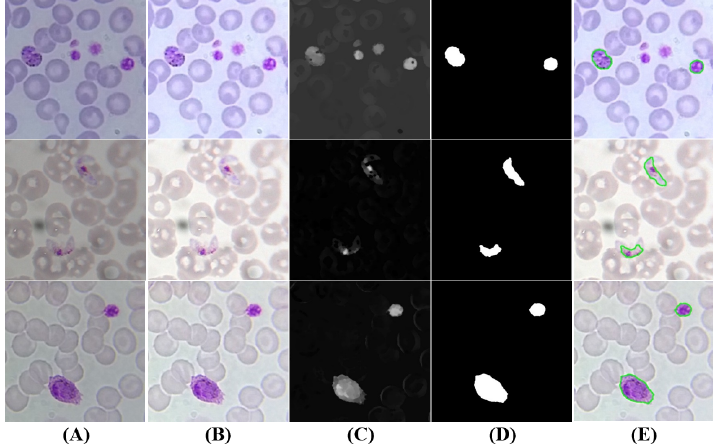
Figure 10. Gametocytes candidates: ( A ) original image (cropped ROI); ( B ) brightness and contrast enhancement; ( C ) grayscale sharpening; ( D ) segmentation and filtering; ( E ) final candidates (at